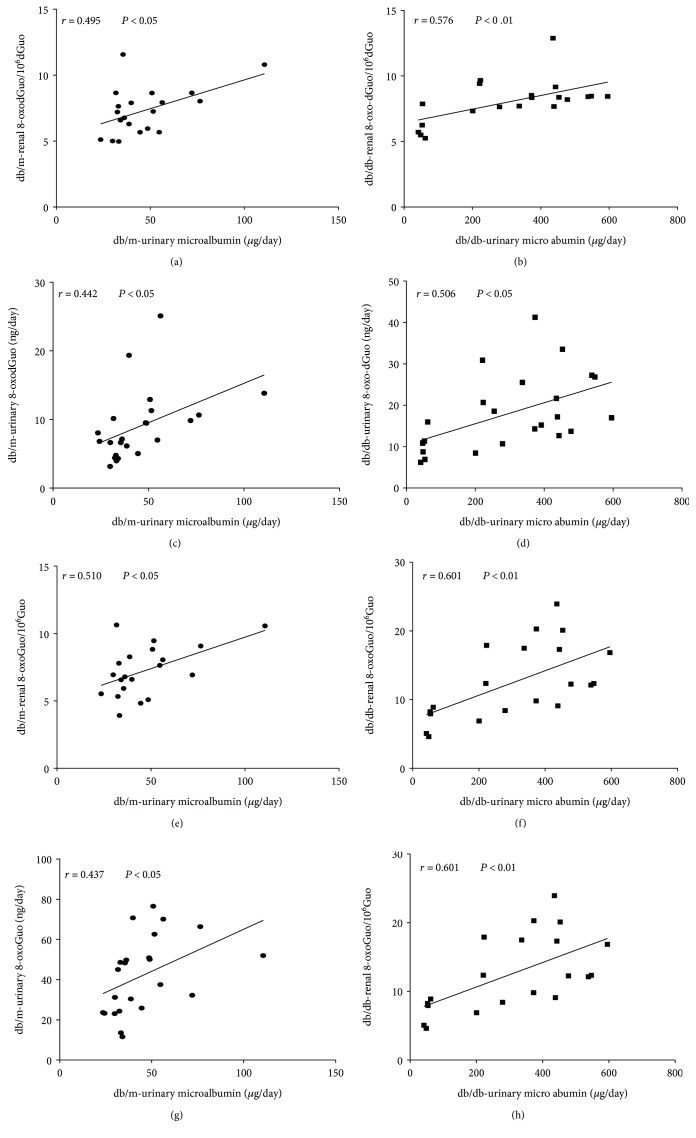
Correlations between 8-oxoGuo/ 8-oxodGuo and urinary microalbumin. (a) Correlation between renal 8-oxodGuo/106dGuo and urinary micro-albumin/day in db/m mice (r = 0.495, P < 0.05). (b) Correlation between renal 8-oxodGuo/106dGuo and urinary microalbumin/day in db/db mice (r = 0.576, P < 0.01). (c) Correlation between 8-oxodGuo and microalbumin per day in urine from db/m mice (r = 0.442, P < 0.05). (d) Correlation between 8-oxodGuo and micro-albumin per day in urine from db/db mice (r = 0.506, P < 0.05). (e) Correlation between renal 8-oxoGuo/106Guo and urinary micro-albumin/day in db/m mice (r = 0.510, P < 0.05). (f) Correlation between renal 8-oxoGuo/106Guo and urinary micro-albumin/day in db/db mice (r = 0.601, P < 0.01). (g) Correlation between 8-oxoGuo and micro-albumin per day in urine from db/m mice (r = 0.437, P < 0.05). (h) Correlation between 8-oxoGuo and microalbumin per day in urine from db/db mice (r = 0.701, P < 0.01).